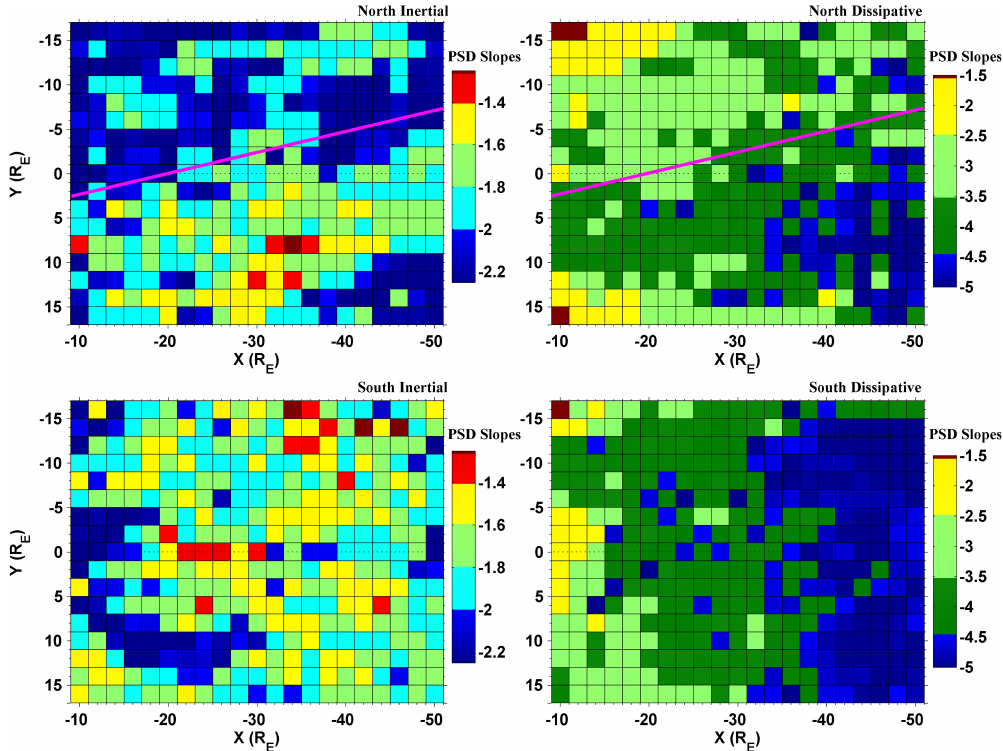
Fig. 5. Distribution of the PSD power law indices in the equatorial plane. These are for northward IMF in the upper panels and for southward IMF in the lower panels. The left hand panels show the inertial range and the right hand panels show the dissipative range. Magenta lines have been drawn that corresponds to the edge of a region on high average resistivity on the dusk side (see Fig.